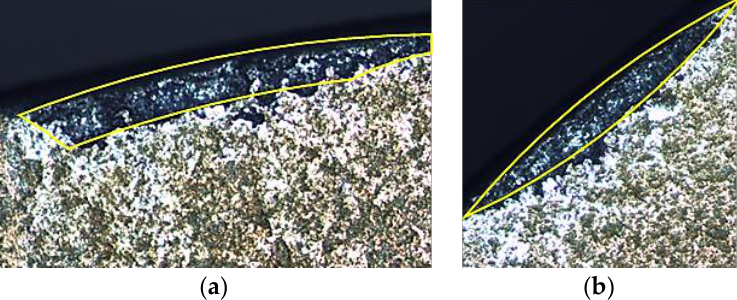
Figure 12. The tool chipping observed during finish milling of the workpiece built with the SSR of 67° under different cutting conditions: ( a ) v c = 90 m/min, f = 0.1 mm/tooth/rev when milling in the XY plane, ( b ) v c = 90 m/min, f = 0.2 mm/tooth/rev when milling in the XY plane.